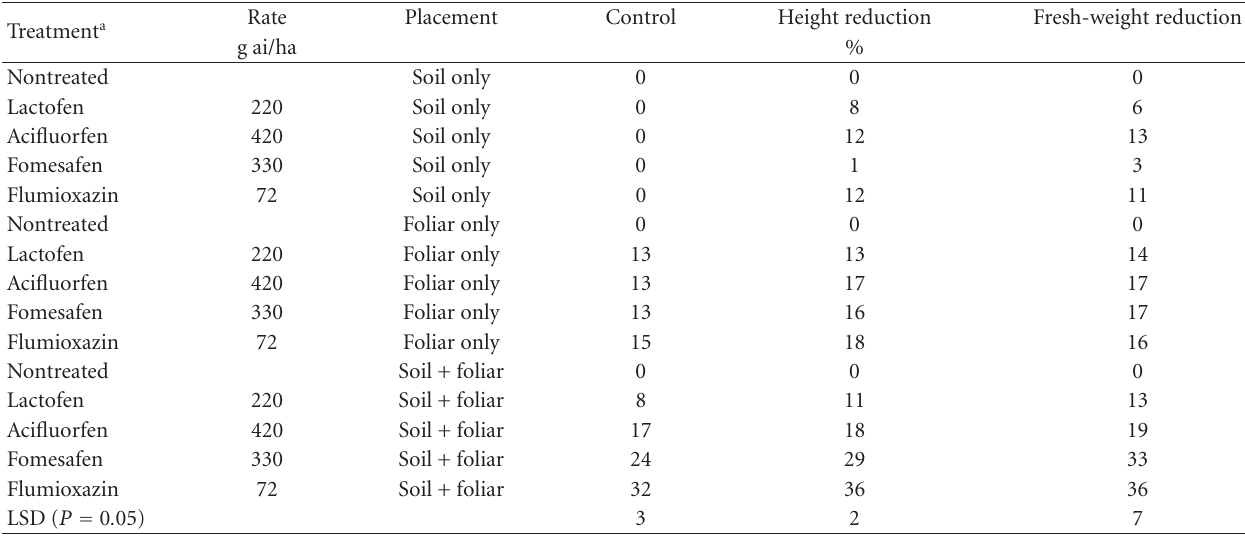
Table 5: The e ff ect of herbicide placement on the response of protox herbicide-resistant common waterhemp. Criteria for evaluating common waterhemp included visual control, height reduction, and fresh-weight reduction 21 d after treatment. Treatment